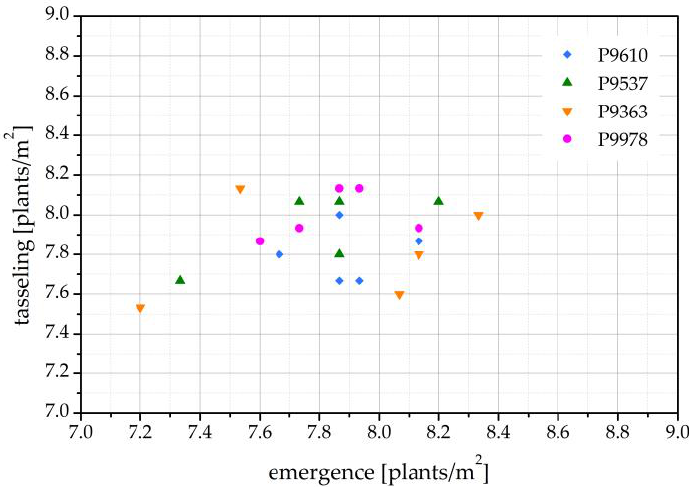
Figure 4. Correlation between the number of emerged seedlings (May) and the number of maize plants at tasseling (August) for the harvest year 2021.